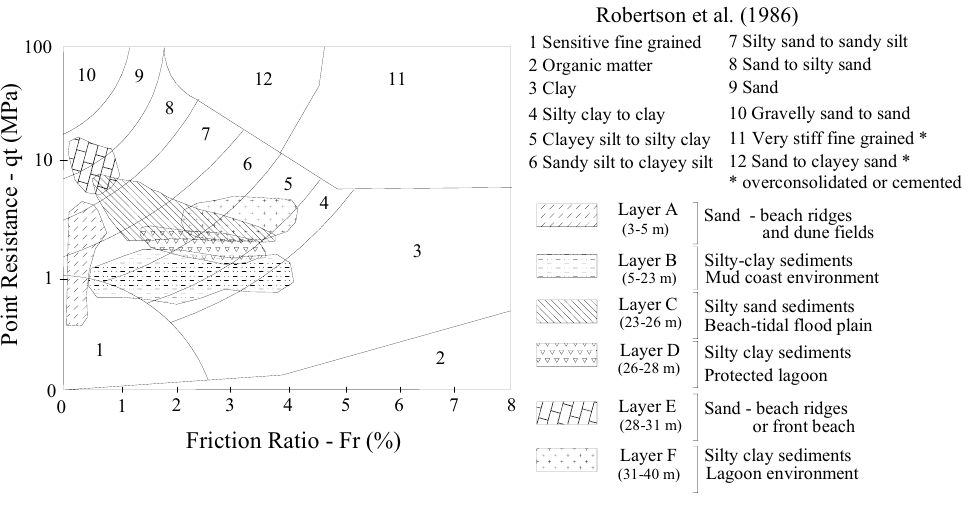
Fig. 12 – Robertson et al. (1986) classification chart and Guarujá’s bay sediment